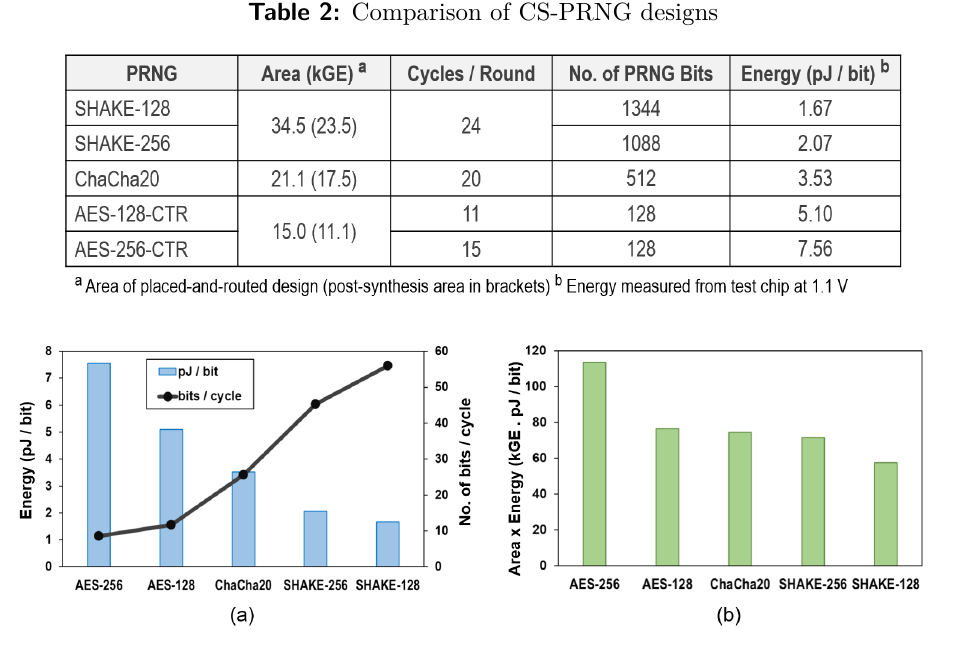
Figure 8: Analysis of SHAKE-128, SHAKE-256, AES-128-CTR, AES-256-CTR and ChaCha20 in terms of energy per bit, bits per cycle and area-energy product.